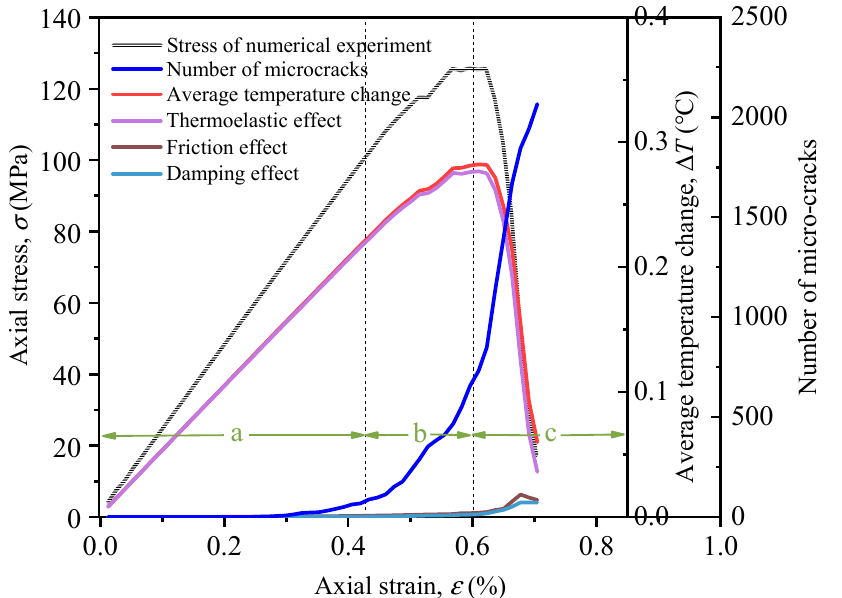
Figure 9. Axial stress, number of micro-cracks, and average temperature change with the axial strain during the numerical experiment under uniaxial compression.